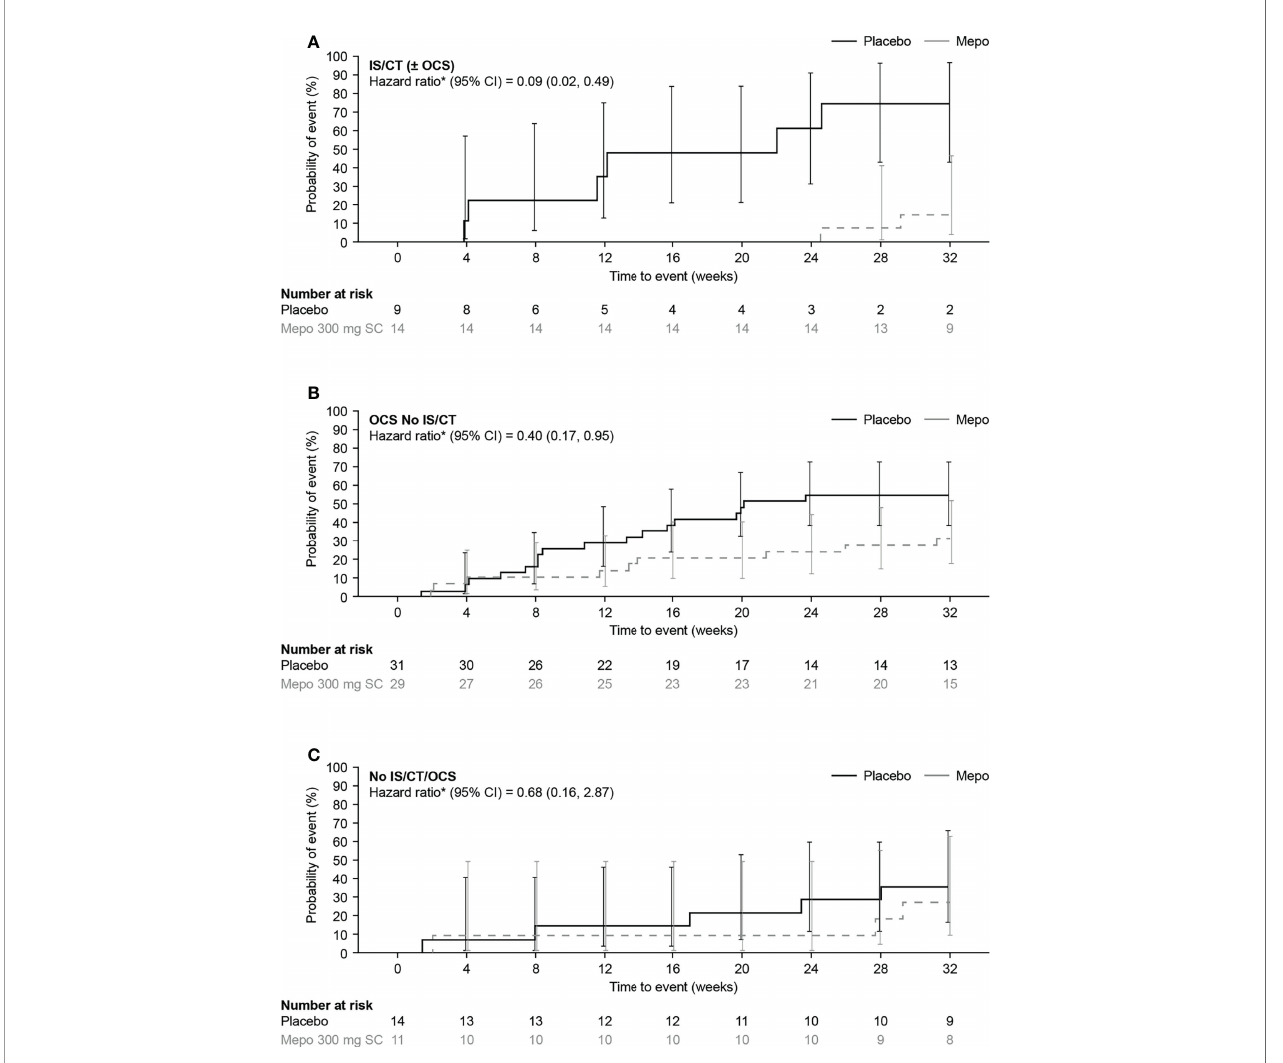
FIGURE 3 | Kaplan-Meier analysis of time to fi rst fl are with mepolizumab versus placebo in (A) IS/CT ( ± OCS), (B) OCS No IS/CT and (C) No IS/CT/OCS subgroups. *Hazard ratio (mepolizumab 300mg SC/placebo) calculated by Cox proportional hazards regression analysis adjusted for baseline OCS dose. CI, con fi dence interval; CT, cytotoxic therapy; IS, immunosuppressive therapy; mepo, mepolizumab; OCS, oral corticosteroid; SC,